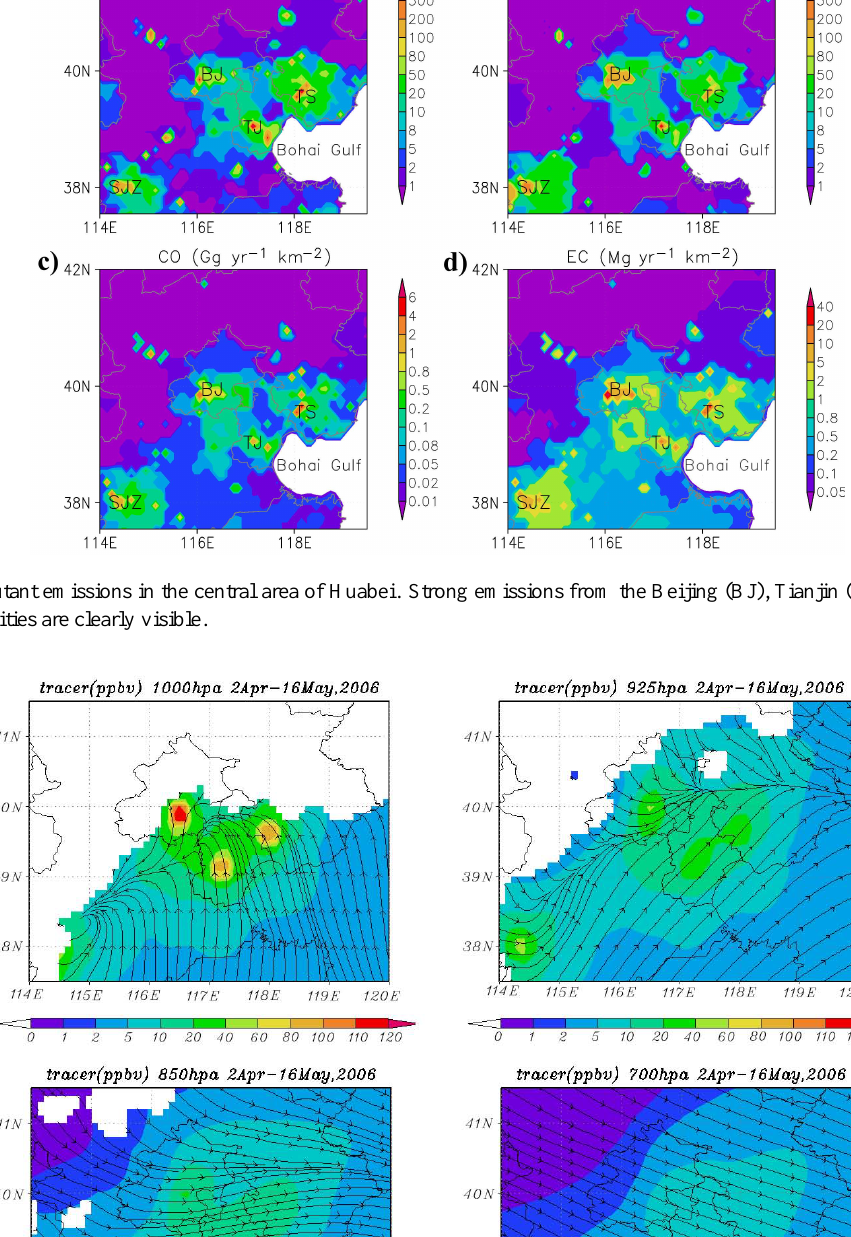
Atmos. Chem. Phys., 12, 3883–3908,